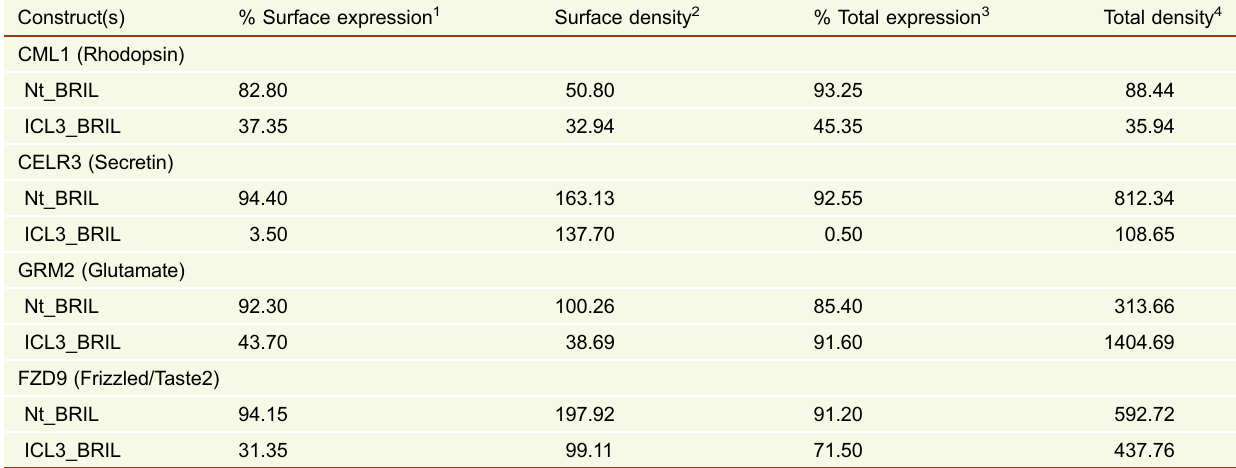
1 Surface expression: The ratio of all the cells expressing the target receptors on the membrane to total cells. 2 Surface density: The ratio of all the fl uorescence of membrane proteins to total cells. 3 Total expression: The ratio of cells expressing the target receptors to total cells. 4 Total density: The ratio of all the fl uorescence to total